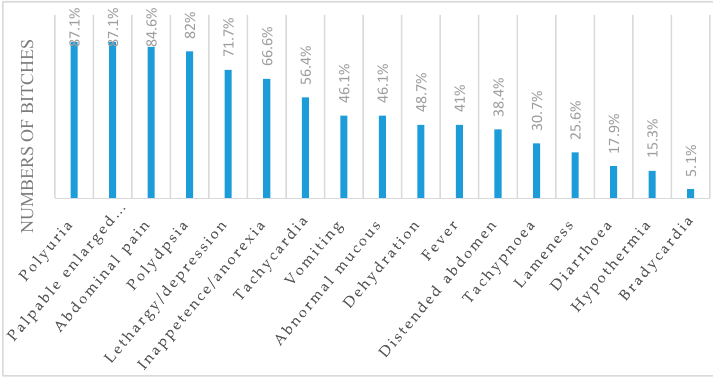
Figure 1. Clinical symptoms and signs in bitches affected with closed-cervix pyometra (CCP).